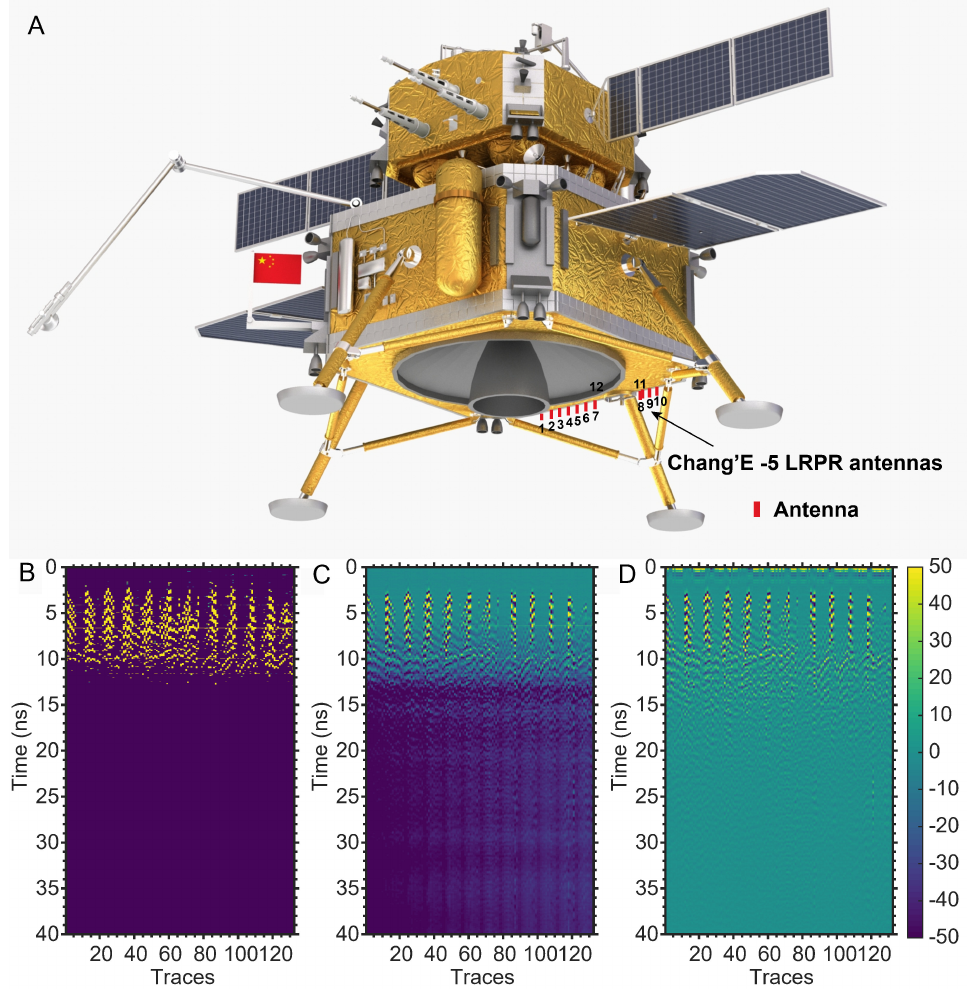
Figure 2. The model and LRP observation data from Chang’E-5. ( A ) The module model of the Chang’E-5 lander; the LRPR is installed at the bottom of the lander (www.turbosquid.com/zh_cn/ 3d-models/chang-e-5-e-model-1681820, accessed on 2 August 2022). ( B ) Raw radar data. ( C ) Radar data after system gain removal and sampling calibration. ( D ) Radargram after band-pass filtering (1–3 GHz)